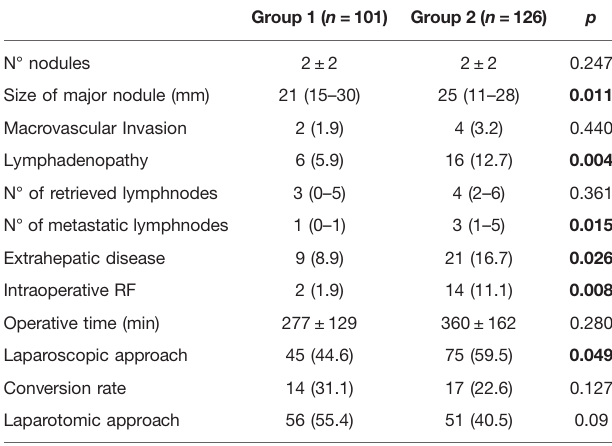
TABLE 4 | Comparison of tumor burden between Group 1 and Group